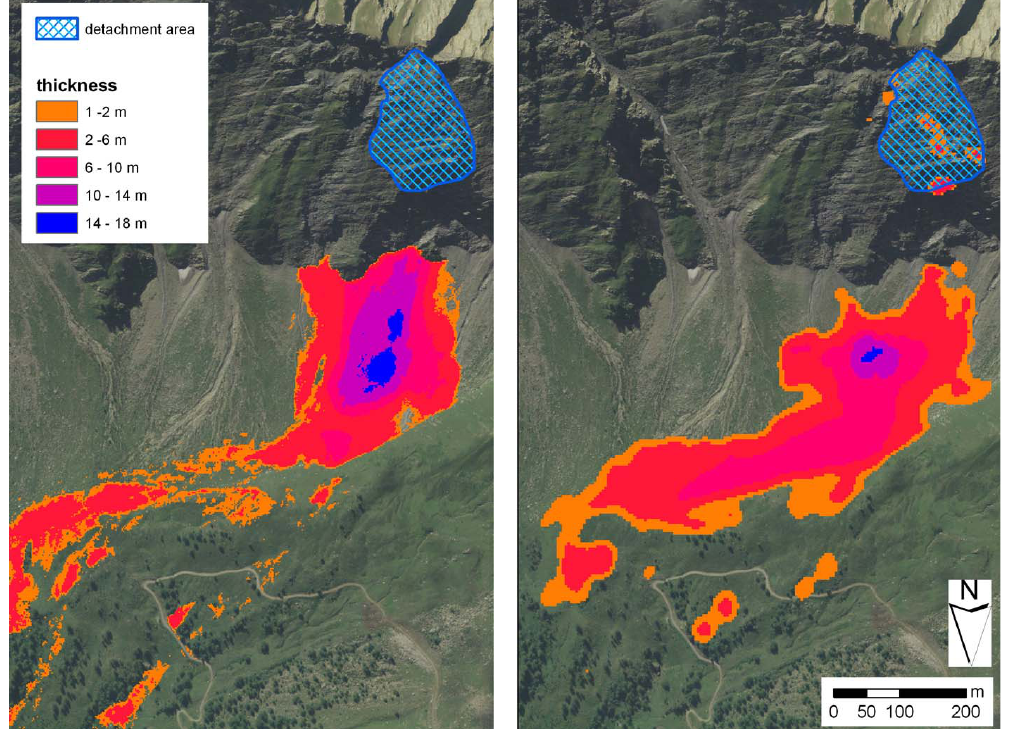
Fig. 13. Comparison between measured (left) and computed by DAN3D (right) rock-avalanche deposit thickness on the scree slope and the plateau.